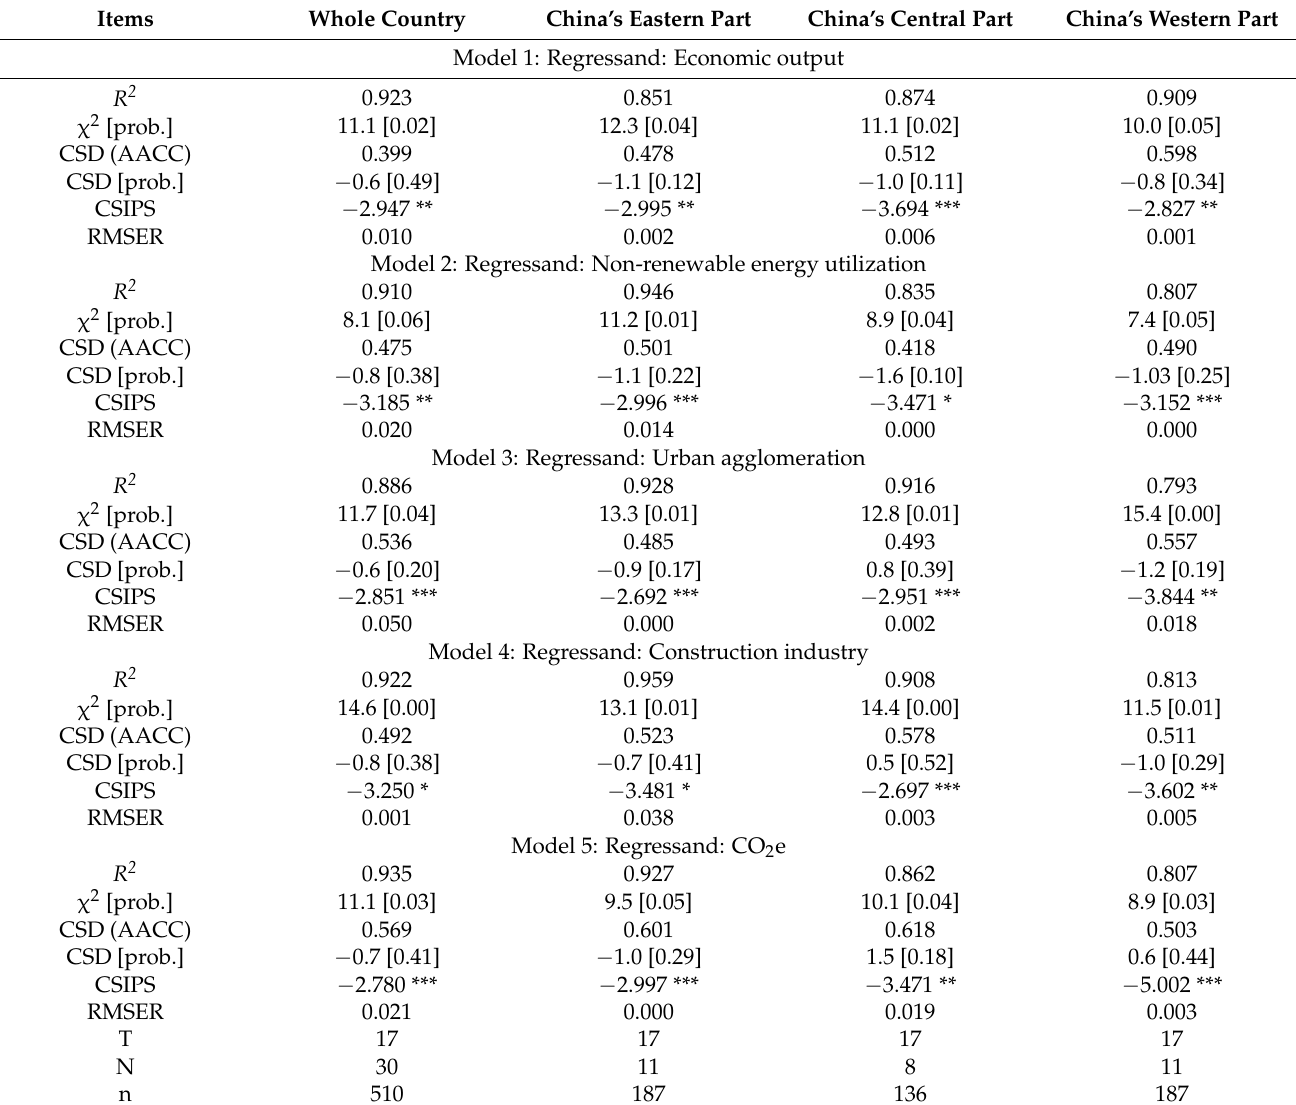
Table 6. Results of diagnostic